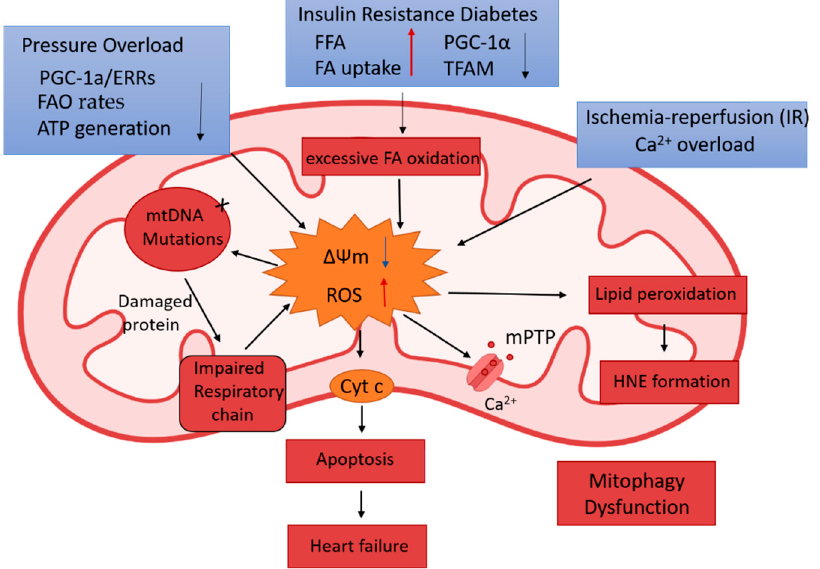
Figure 3. The production of ROS in mitochondria and its oxidative damage in different cardiac diseases. The increased ROS and the decreased mitochondrial membrane potential ( ∆Ψ m) may lead to mtDNA mutation, impaired respiratory chain, lipid peroxidation, and mPTP opening, resulting in the release of cytochrome c (Cyt c), cell apoptosis, and heart failure. ROS: reactive oxygen species.